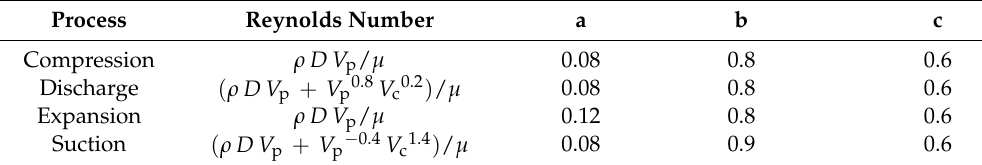
Table 2. Reynolds number and constant values in Equation (20) [22]. ( ρ is fluid density (kg/m 3 ), V p is the average flow velocity (m/s), D is the hydraulic diameter (m), µ is the dynamic viscosity coefficient